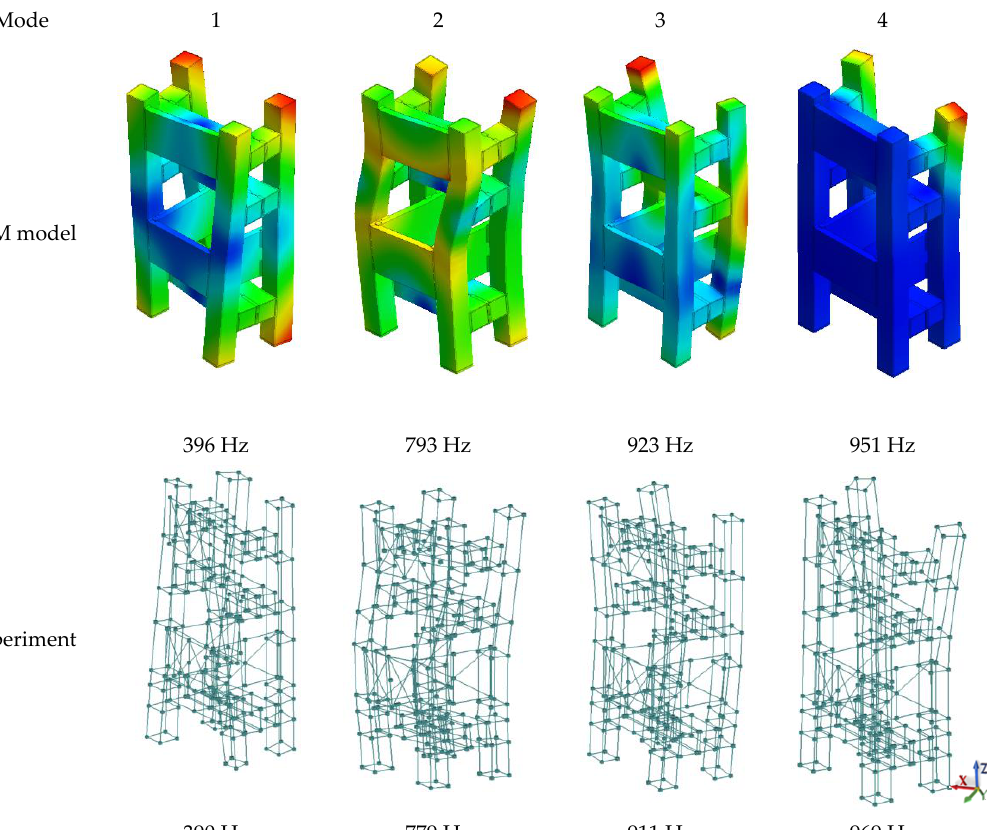
Figure 13. Comparison of selected calculated and experimentally determined mode shapes for the complex steel–polymer concrete frame.